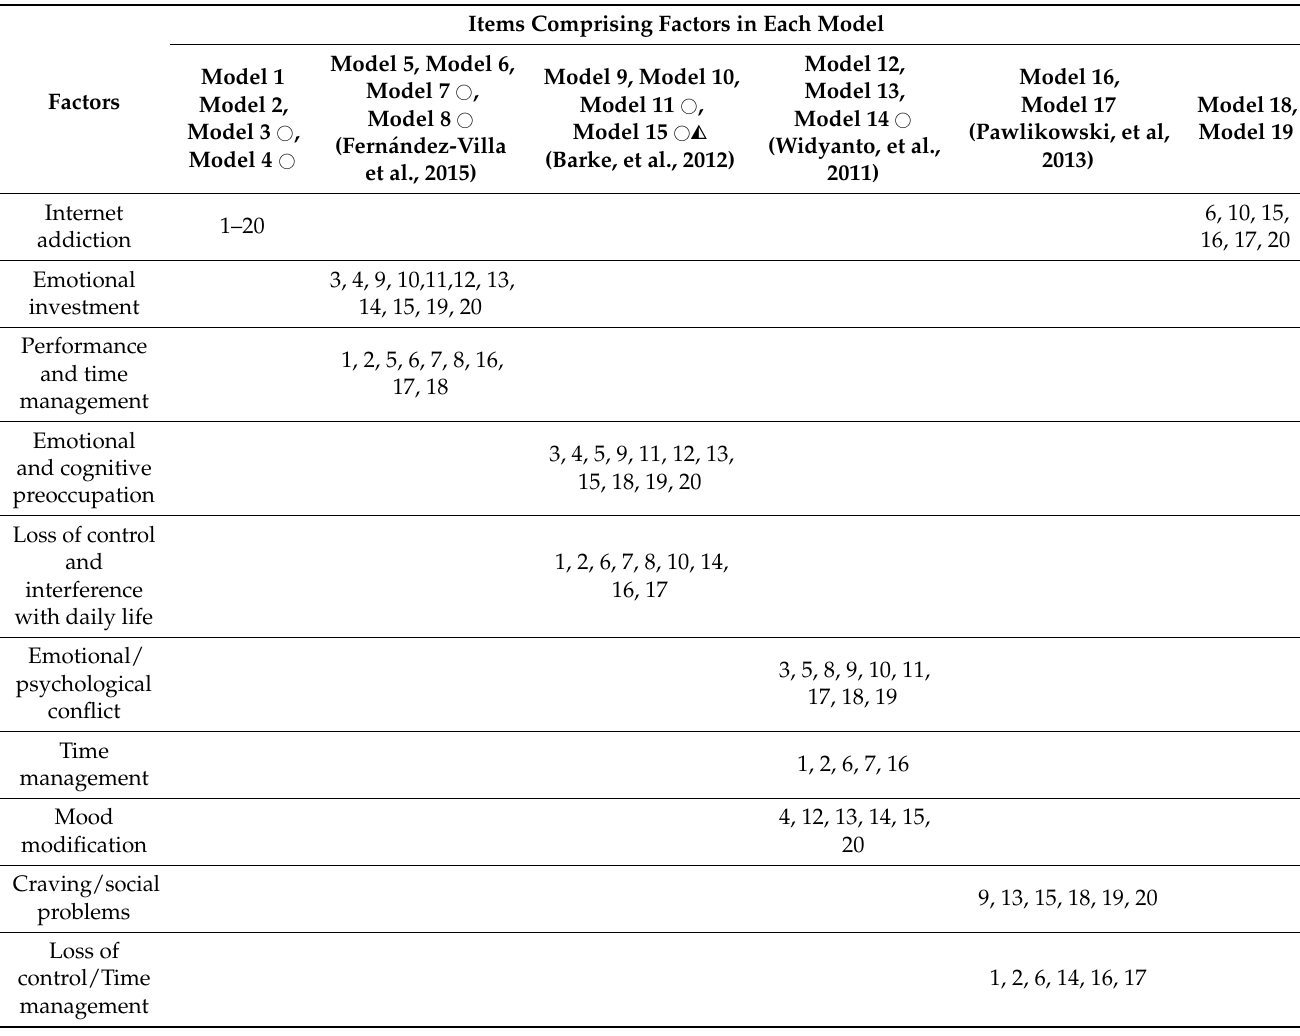
Table 1. Models proposed for the factor structure the Internet Addiction Test and items on each corresponding factor.